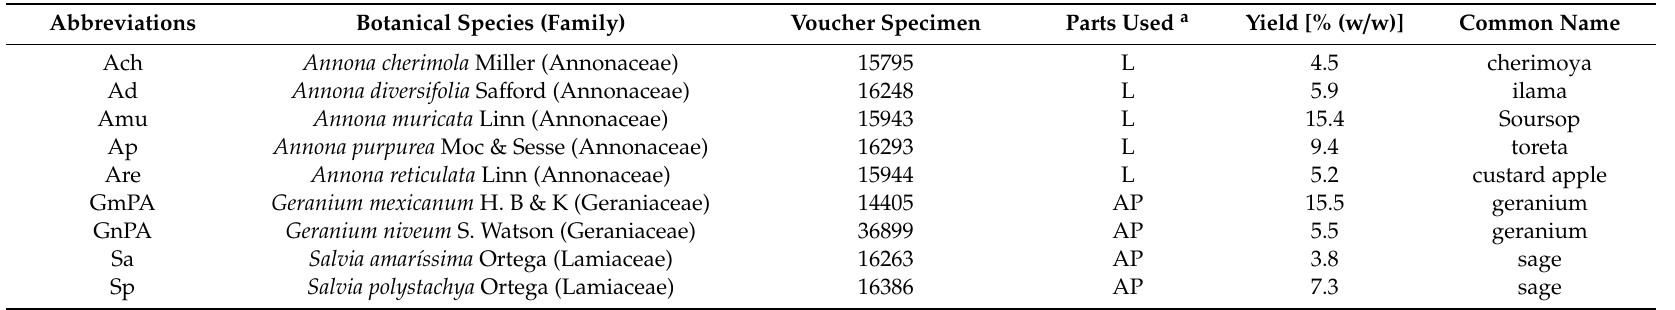
Table 1. Medicinal plants